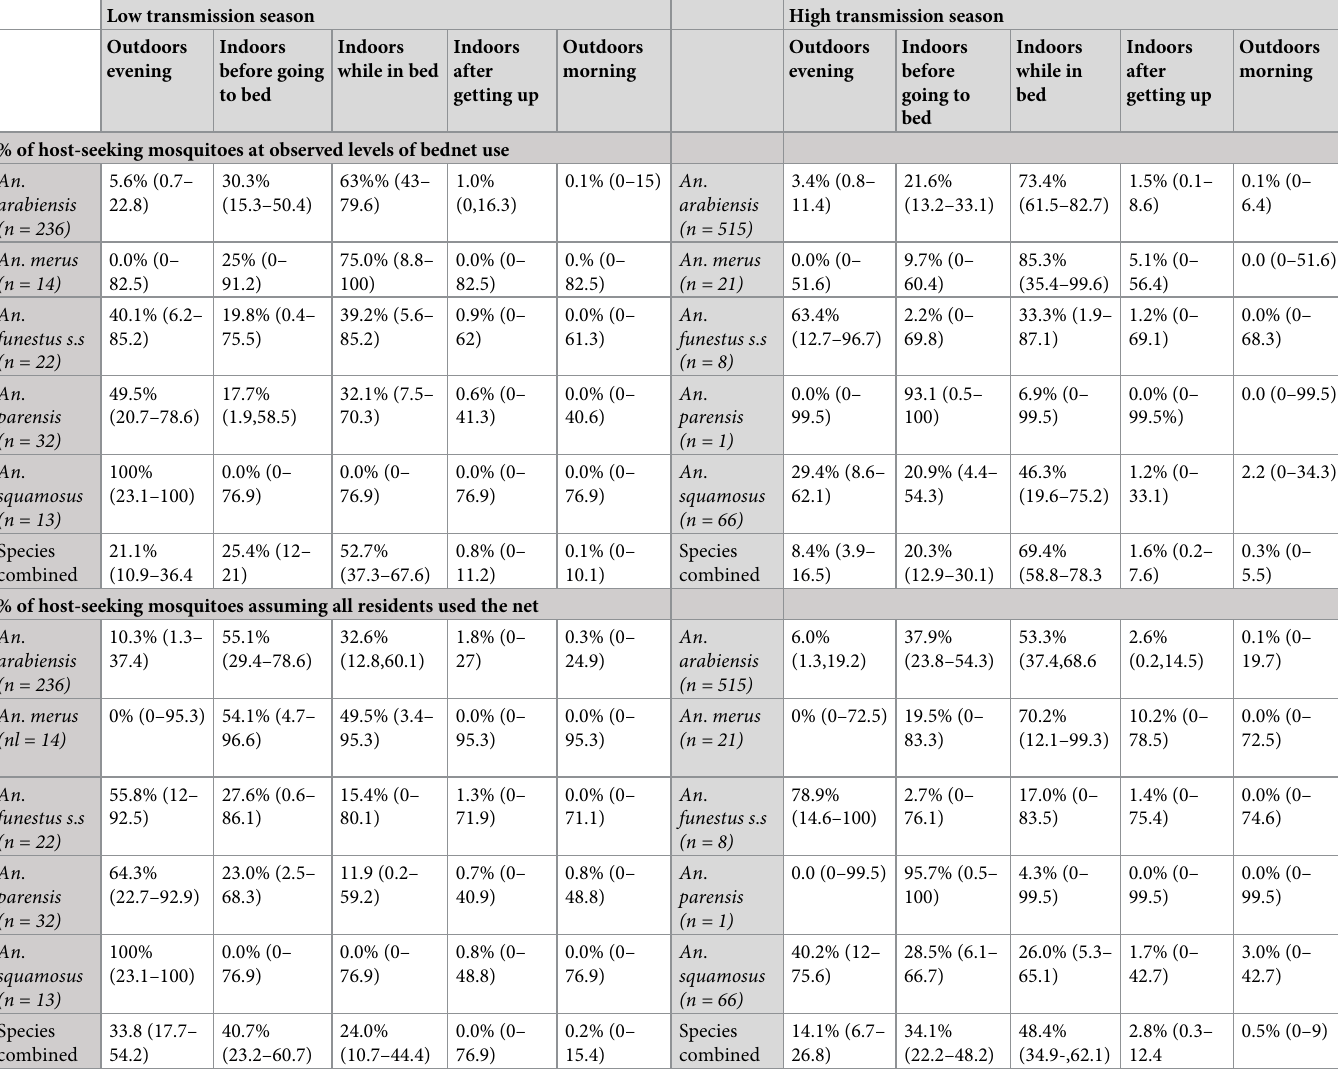
Table 3. Percentage of host seeking mosquitoes of each of the five vector species that Magude residents were exposed to in each of the five environments where humans and vectors have the opportunity to interact. These environments are i) outdoors before going indoors, ii) indoors before going to bed, iii) indoors while in bed, iv) indoors after getting up, and v) outdoors after leaving the house again. Percentages are given for the low and high transmission seasons separately, and for the observed levels of bednet use, or assuming a hypothetical scenario in which all residents used a net when in